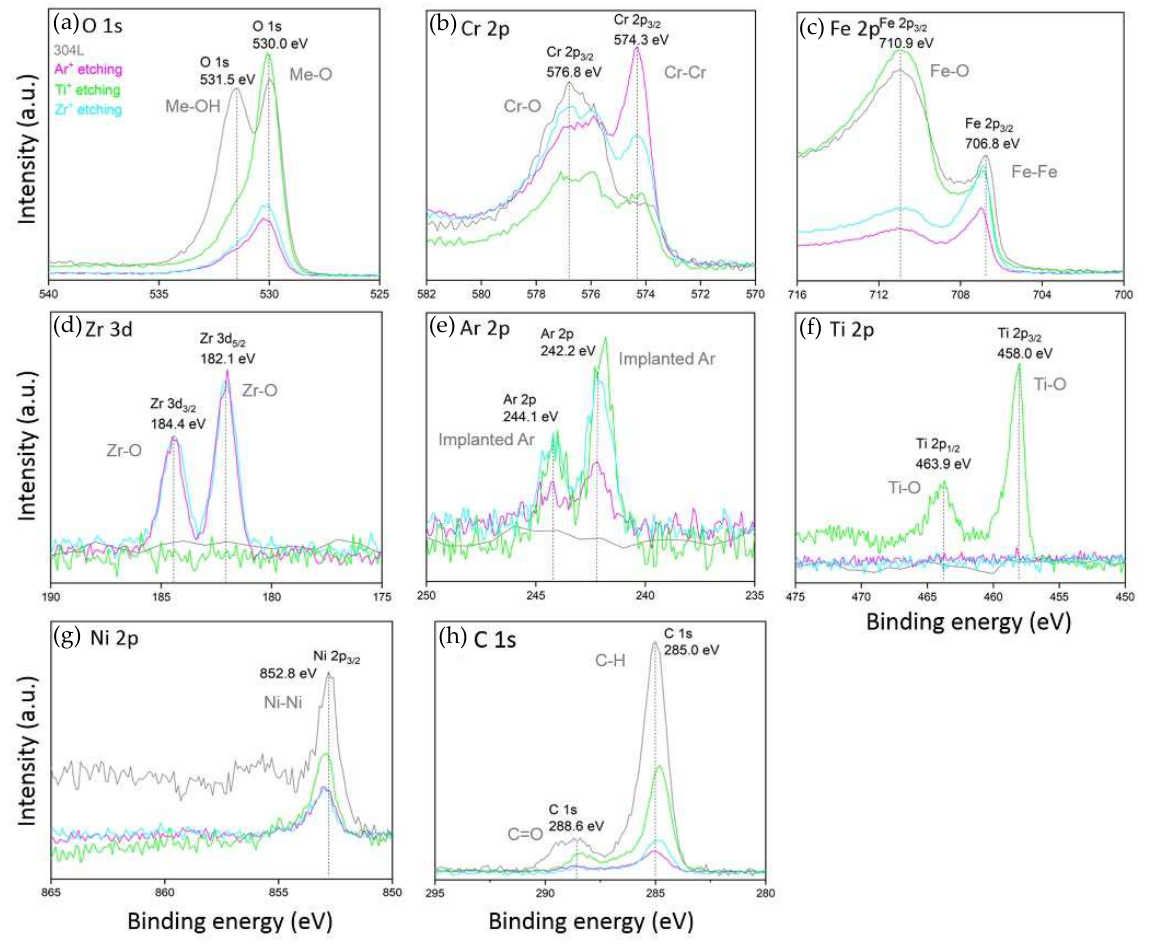
Figure 3. High-resolution XPS spectra of ( a ) O 1s, ( b ) Cr 2p 3/2 , ( c ) Fe 2p 3/2 , ( d ) Zr 3d, ( e ) Ar 2p, ( f ) Ti 2p, ( g ) Ni 2p and ( h ) C 1s of raw and etched 304L samples.